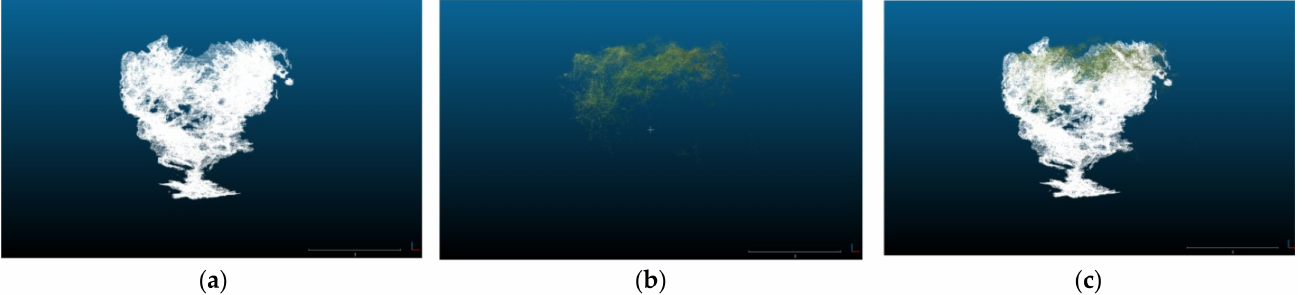
Figure 8. Point clouds of a sample tree derived by the UGV-ZED depth camera ground-based system ( a ), the UAV based aerial system ( b ), and the fusion of the two point clouds ( c